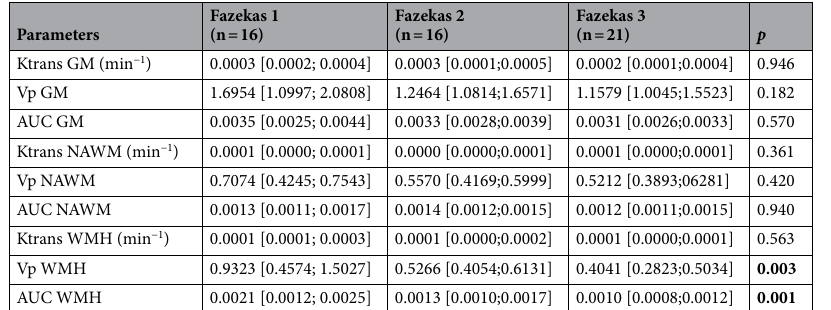
Table 5. DCE-MRI parameters based on the Fazekas score. Significant values are in bold.